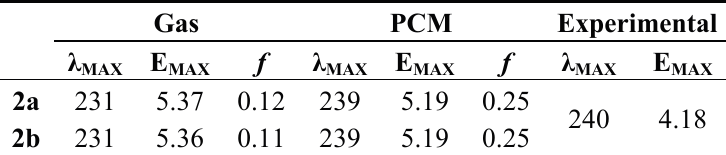
Table 1. Calculated λ the B3LYP/6–31+G(d,p) level of theory.